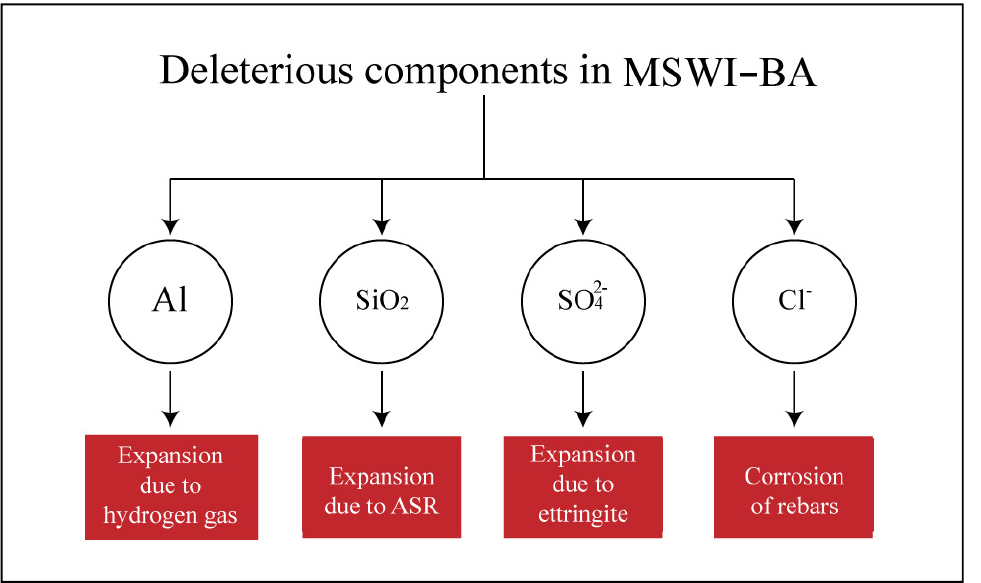
Figure 1. Limitations of using MSWI-BA as aggregates in cementitious materials.